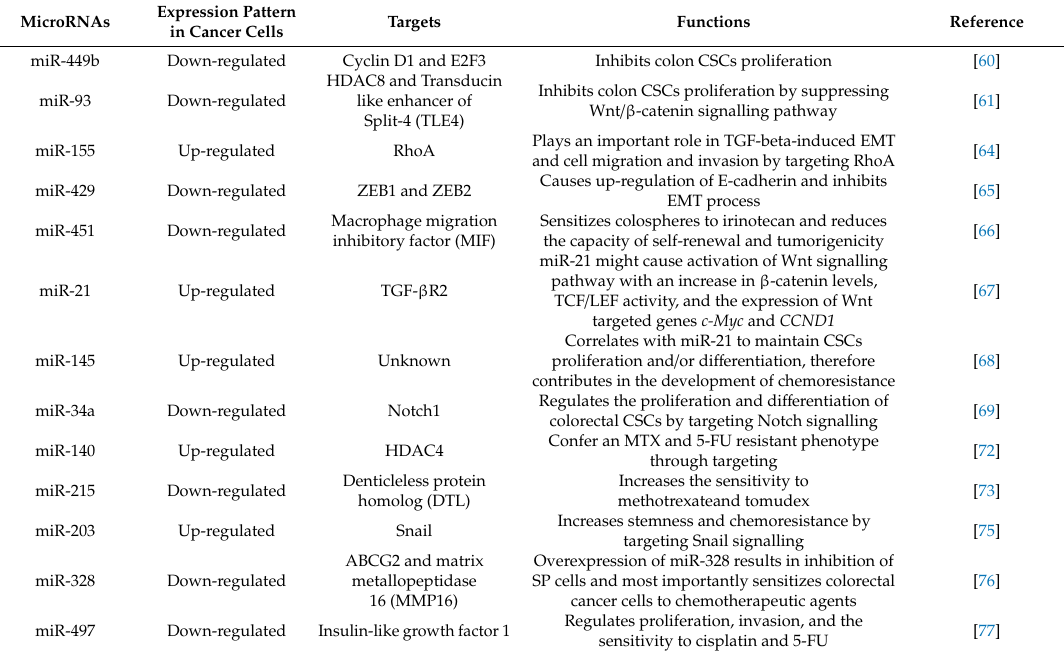
Table 2. miRNAs associated with the therapy resistance property of colorectal